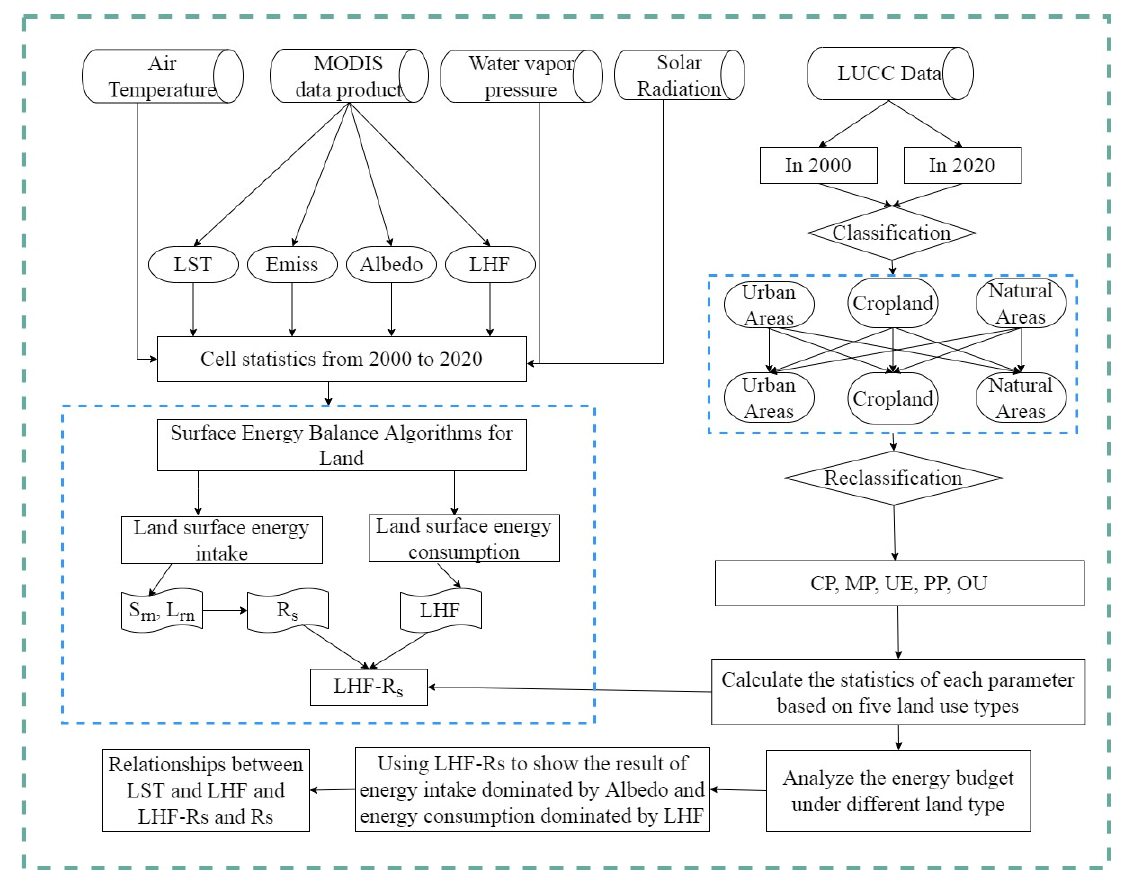
Figure 3. Research framework of energy budget feedback of land use change.